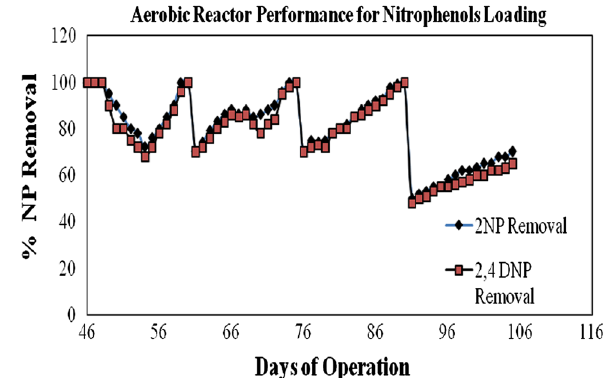
Fig. 4 Nitrophenol removal efficiency for anaerobic reactors